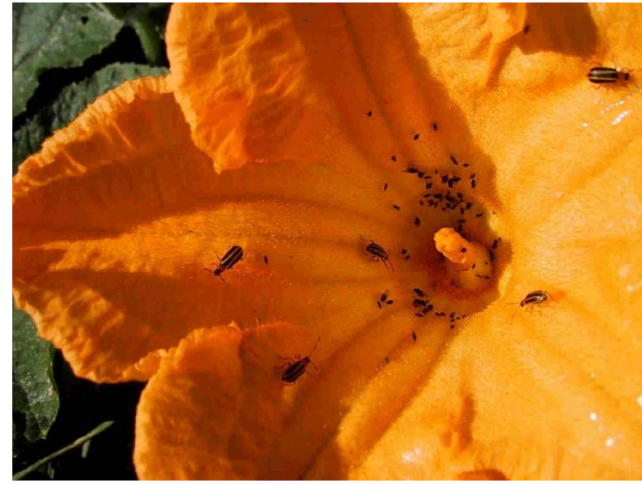
Figure 2. Flower of Cucurbita pepo L. with several Diabroticite beetles of the species Acalymma blomorum Munroe & Smith 1980 in the surroundings of Coatepec, Ver., Mexico (Photo: A.